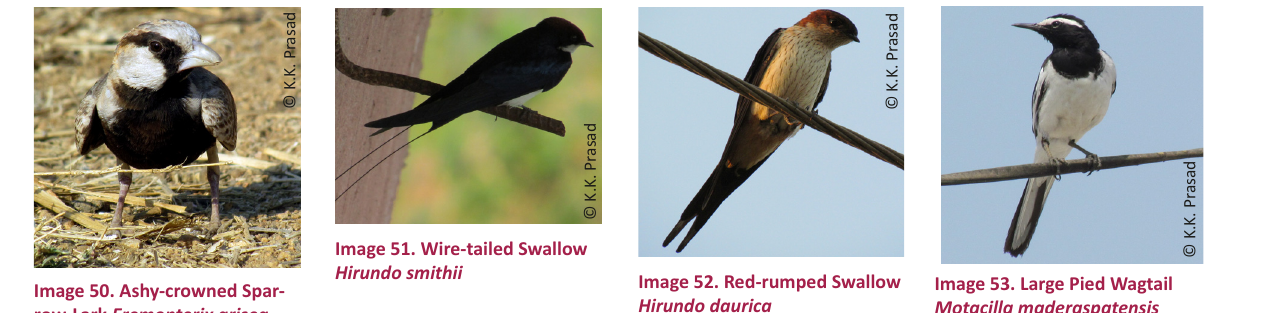
Hirundo daurica